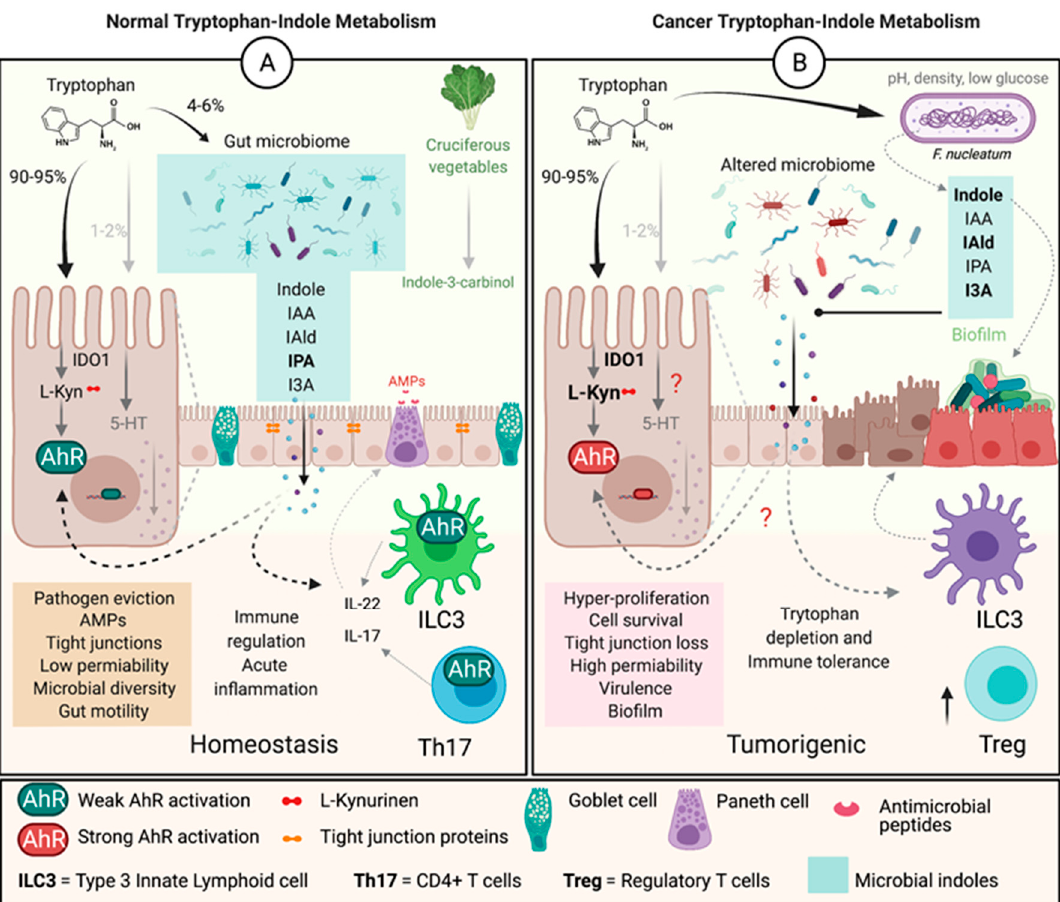
Figure 2. Tryptophan-indole metabolism in normal vs. colon carcinogenesis. ( A ) Under normal physiological conditions, Trp is mainly metabolised by hepatic or extrahepatic cells by IDO1 into L-Kyn, with the rest being metabolised by bacteria or converted to 5-hydroxytryptamine or seratonin. The bacteria convert Trp to indoles, and together with dietary indoles, IDO1 and L-Kyn are ligands for AhR. Indoles also regulate the production of cytokines in by ILC3 and Th17 cells, which result in production of AMPs and improved barrier function to regulate inflammation and maintain homeostasis. ( B ) In a tumorigenic environment IDO1 is overexpressed and Trp is depleted driving L-Kyn levels higher and constiuatively activating AhR. High L-Kyn leads to potentially stronger AhR activation and overproduction of IL-22/IL-17 and hyperproliferation, along with activation of Treg cells creating an immunotolerant environment permissive for tumor growth. It is unclear (?) how microbial indolic metabolites control epithelial or immune cell metabolism in the context of colon cancer.